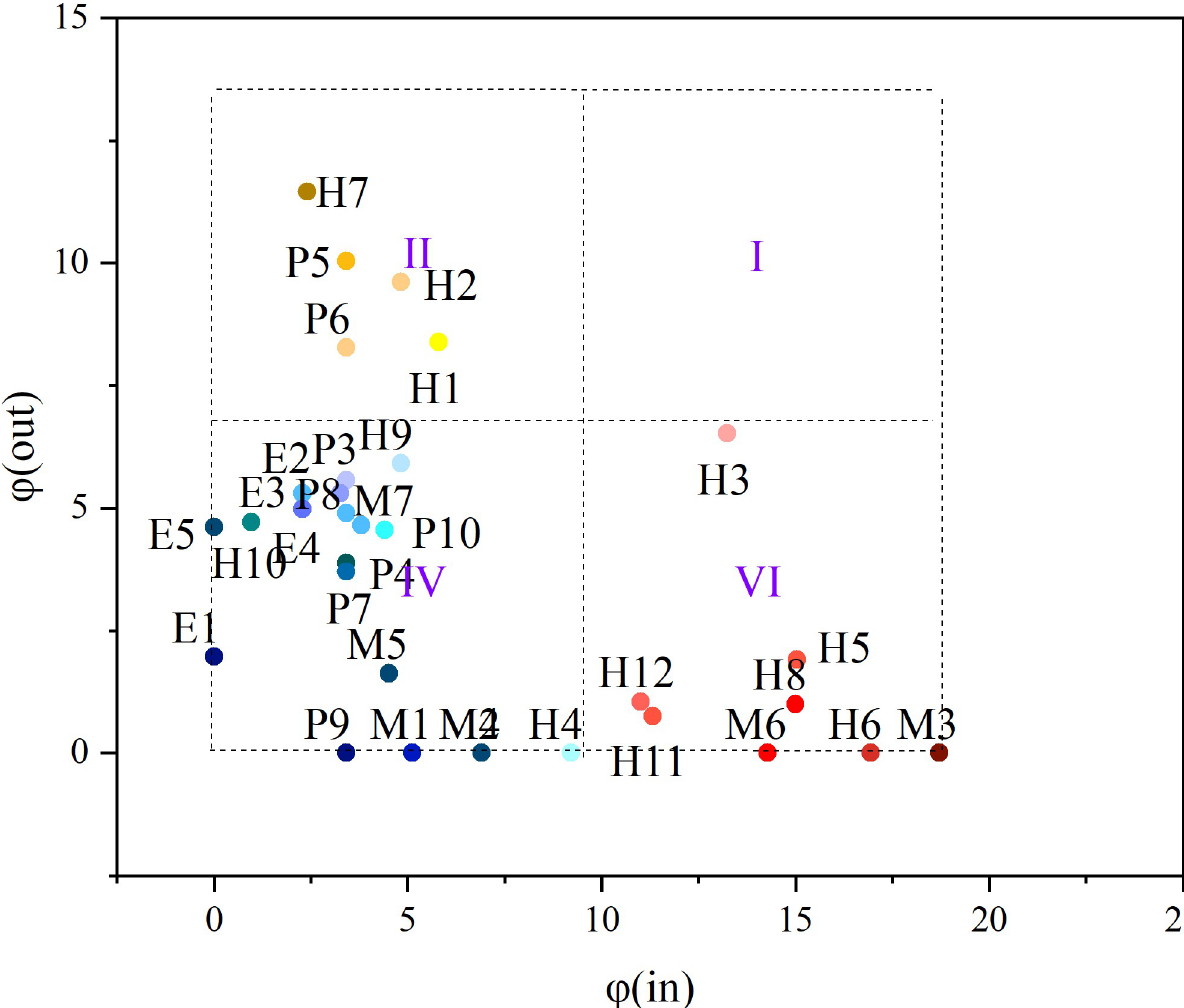
Fig 7. Diagram of the two-dimensional topological potential